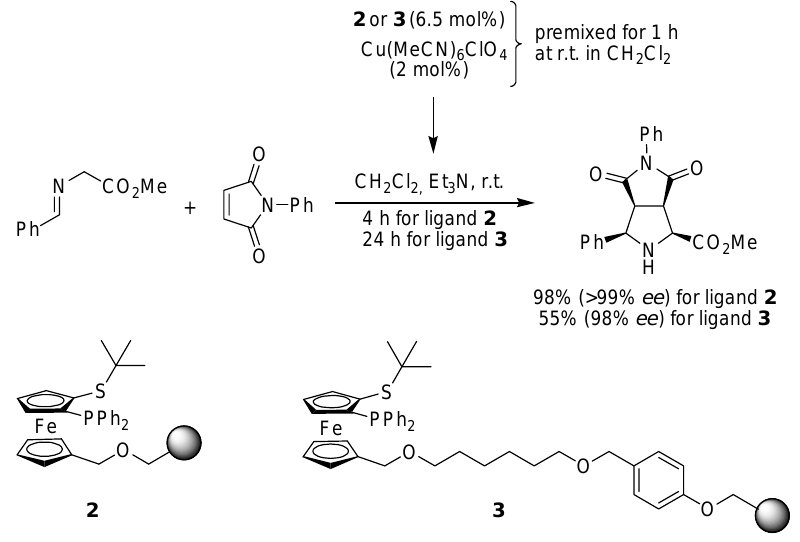
Scheme 2. Application of polymer-bound Fesulphos ligands in the copper-catalyzed 1,3- dipolar cycloaddition of an imine to N